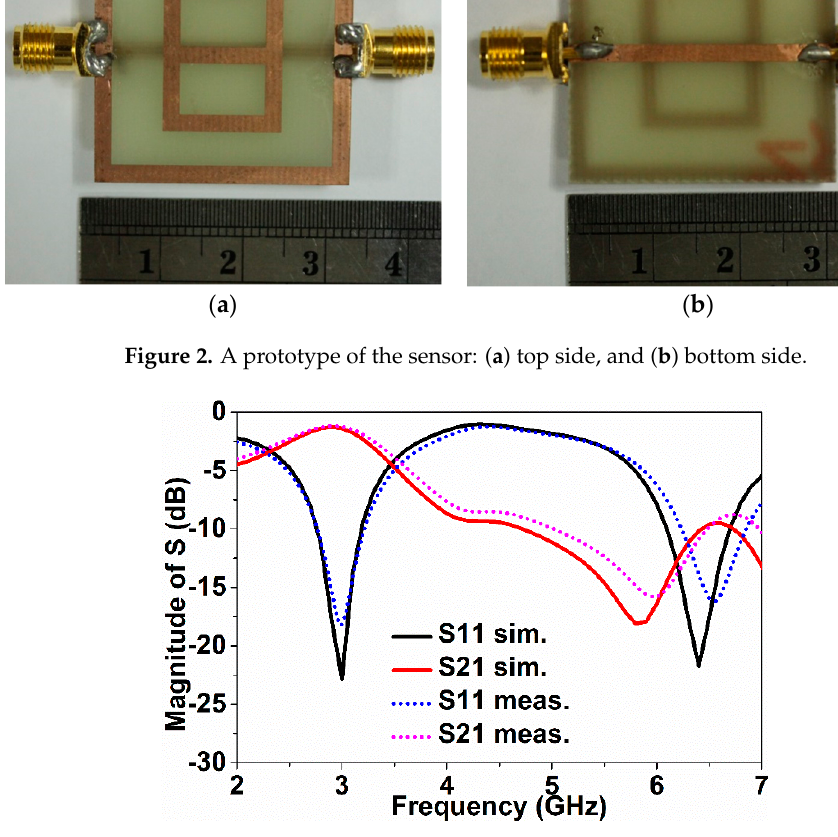
Figure 3. The magnitude of the S-parameter.